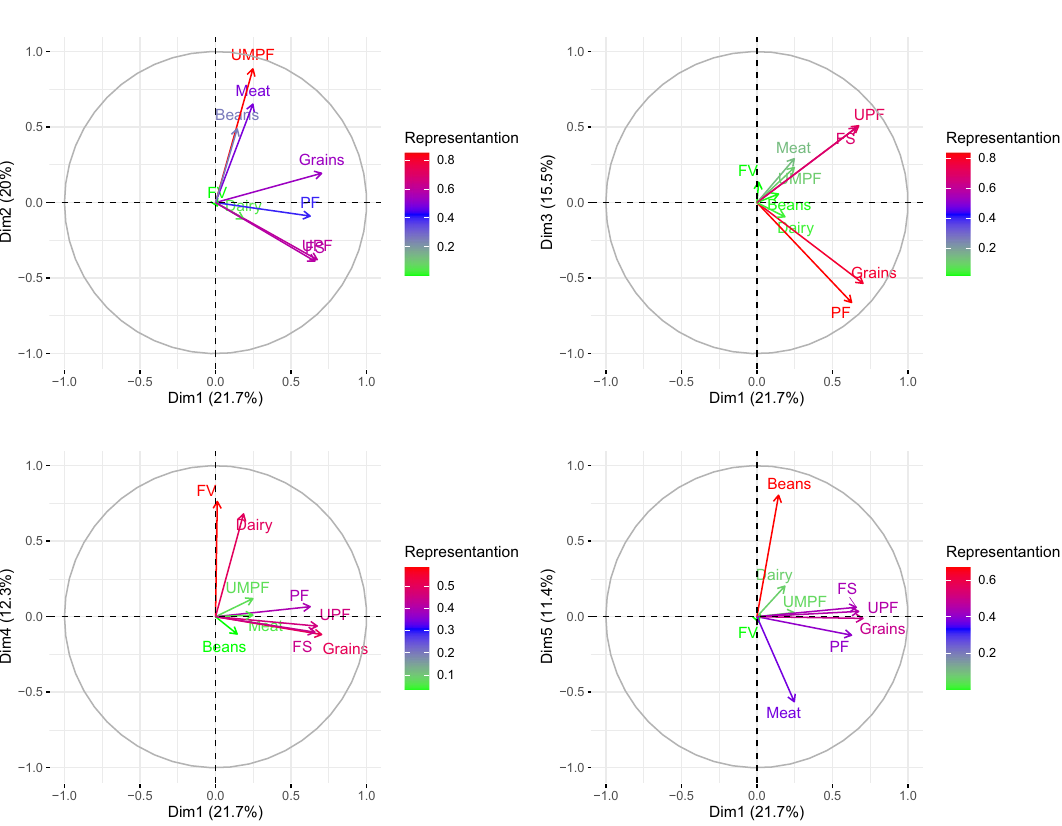
Figure 2. Perceptual map of interrelationships and correlations between dimensions of dietary patterns. Image obtained from the R software. UMPF Unprocessed and minimally processed food, PF processed food, UPF ultra-processed food, FV fruits and vegetables, Meat meat and eggs, FS fats and